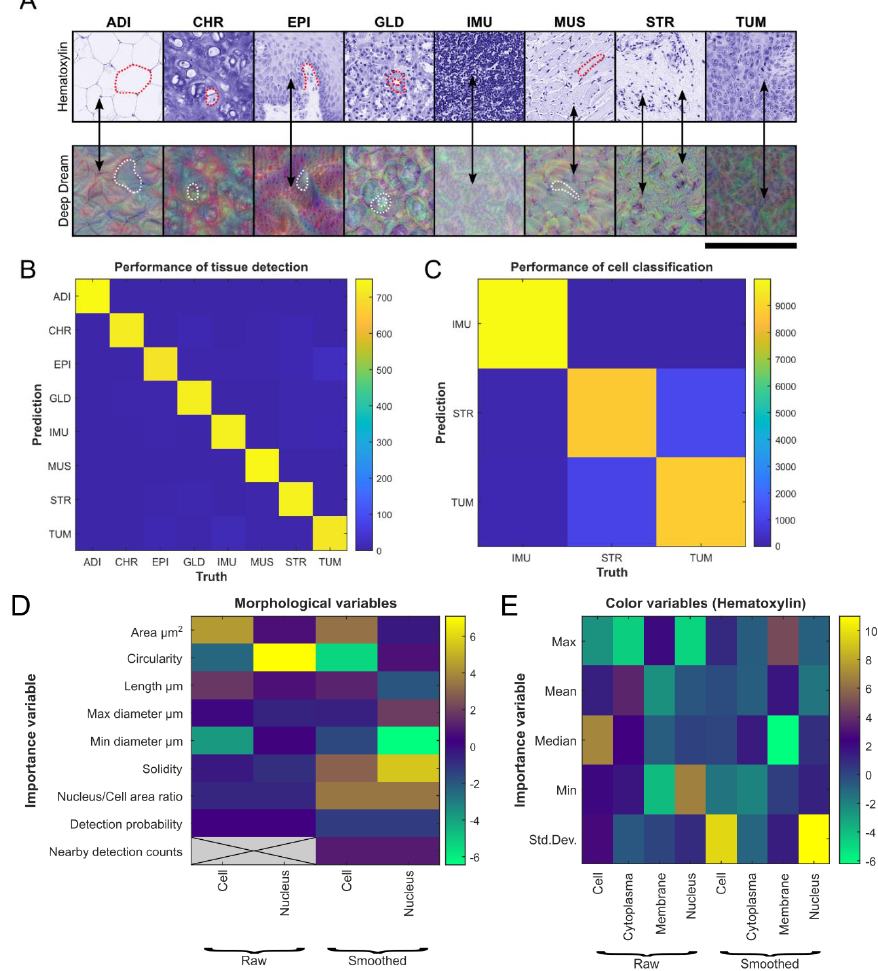
Figure 2. Neural Network Performance and Deep Dream. ( A ) Hematoxylin-stained tile images of the 8 tissue classes are shown in the top row. In the bottom row, abstractions of histological tissue classes are visualized using “ Deep Dream ” method, which the trained CNN “ shufflenet ” can recognize: ADI (adipose tissue): Vesicular structures and star-shaped retractions corresponding to vacuoles and nuclei; CHR (cartilage tissue): Typical configuration of chondrocytes; EPI (epithelium): Stratification of cells based on a basal lamina; GLD (glandular tissue): Cloudy structure corresponding to glands with a central lumen; IMU (immune cells): Grape-shaped collections of cells. MUS (muscle tissue): Muscle fibers both transversely and longitudinally sectioned with associated nuclei. STR (stromal tissue): Single cell nuclei embedded in a network of collagen fibers; TUM (tumor tissue): Cells of different sizes without recognizable basal lamina. Important structures are shown by dotted lines (hematoxylin: In red; deep dream: in white). The black arrows point to individual cells in hematoxylin and deep dream images. Scale bar equals 256 µm. ( B ) Accuracy of the 1st neural network (CNN “ shufflenet ” ) based on 6000 tile test images (750 per class). ( C ) Accuracy of the 3rd neural network (MLP ANN) based on 30,000 detected cells (normalized to 10,000 per class). ( B , C ) The x -axis shows the true class and the y -axis shows the prediction. ( D , E ) Importance variables of the third neural network (MLP ANN) (Olden et al. 2004). ( y -axis): the variables correspond to morphological or color properties of the recognized cells. ( x -axis): raw and smoothed data with 25 µm. A strong yellow or green color corresponds to a high importance variable. Nearby detection counts exists only for smoothed data.